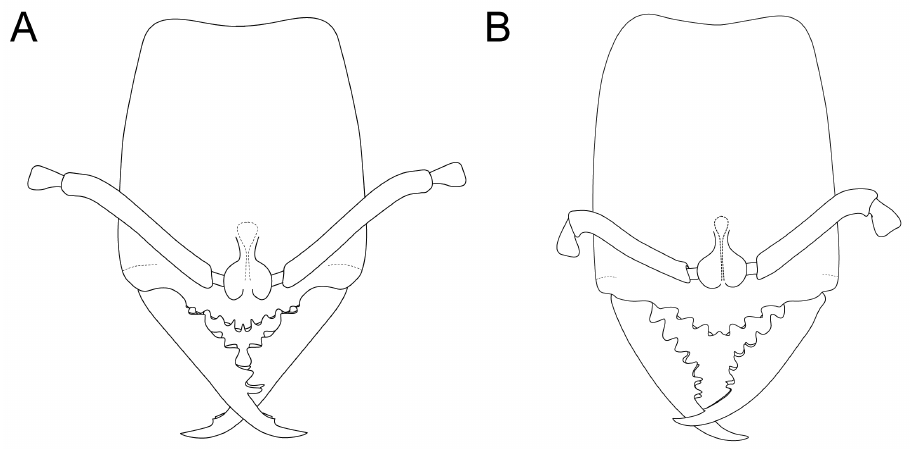
Mandible bearing four teeth (including indistinct pre-apical tooth, and apical tooth). Anterior clypeal margin bearing five stout, dentiform setae. Frontal lobes relatively separated by median portion of clypeus (Figure 7A) ........ S . scrobiceps – Mandible bearing six teeth (including pre-apical and apical teeth). Anterior clypeal margin bearing seven stout, dentiform setae. Frontal lobes closely ap- proximated (Figure 7B) ............................................................. S . crypticum Median mandibular teeth jigsaw-tab-shaped ............................................... 6 – Median mandibular shaped otherwise, but never as jigsaw-tabs .................. 7 6 Clypeal setae rising from small tubercular projections of the anterior clypeal margin. Head rectangular, longer than wide (CI: 84; Xu 2000). Mandibles shorter than head (ML: 0.30, HL: 0.38; Xu 2000) (Figure 8A) .... S. mulanae – Clypeal anterior margin flat: clypeal setae rise from the anterior portion of the median area of the clypeus, not from the clypeal anterior margin. Head quadrate, as long as wide (CI: 100). Mandibles as long as head (MI: 100) (Figure 8B) ........................................................................... S. luyiae sp. n. 7 In full-face view, head trapezoidal: anterior margin much wider than pos- terior margin; slightly broader than long (CI: 101.9; Baroni Urbani 1978). Posterior margin of the head concave. Mandibular pre-apical tooth compara- tively large. Anterior clypeal margin bearing eight stout, dentiform setae (Fig- ure 9A) ....................................................................................... S . pertinax In full-face view, head rectangular: anterior margin as wide as posterior mar- gin; longer than broad (CI: 82-88; Onoyama 1999). Posterior margin of the head straight. Mandibular pre-apical tooth indistinct. Anterior clypeal mar-